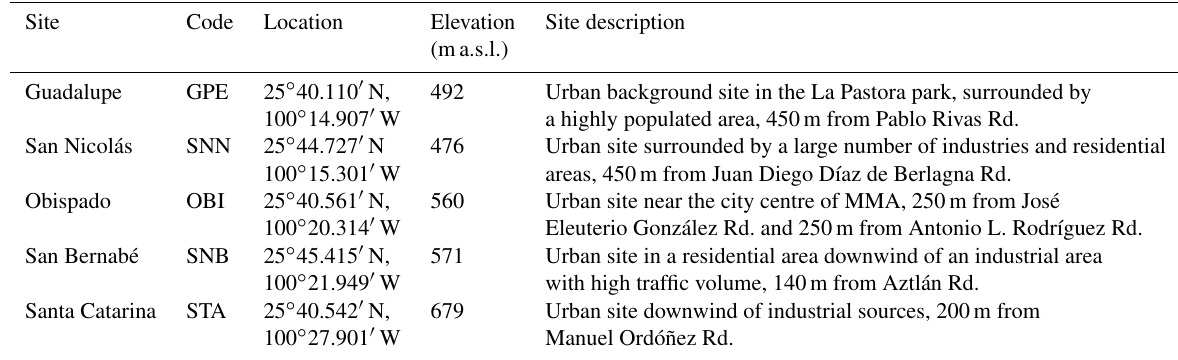
Table 2. Site description and location of the five monitoring sites within the